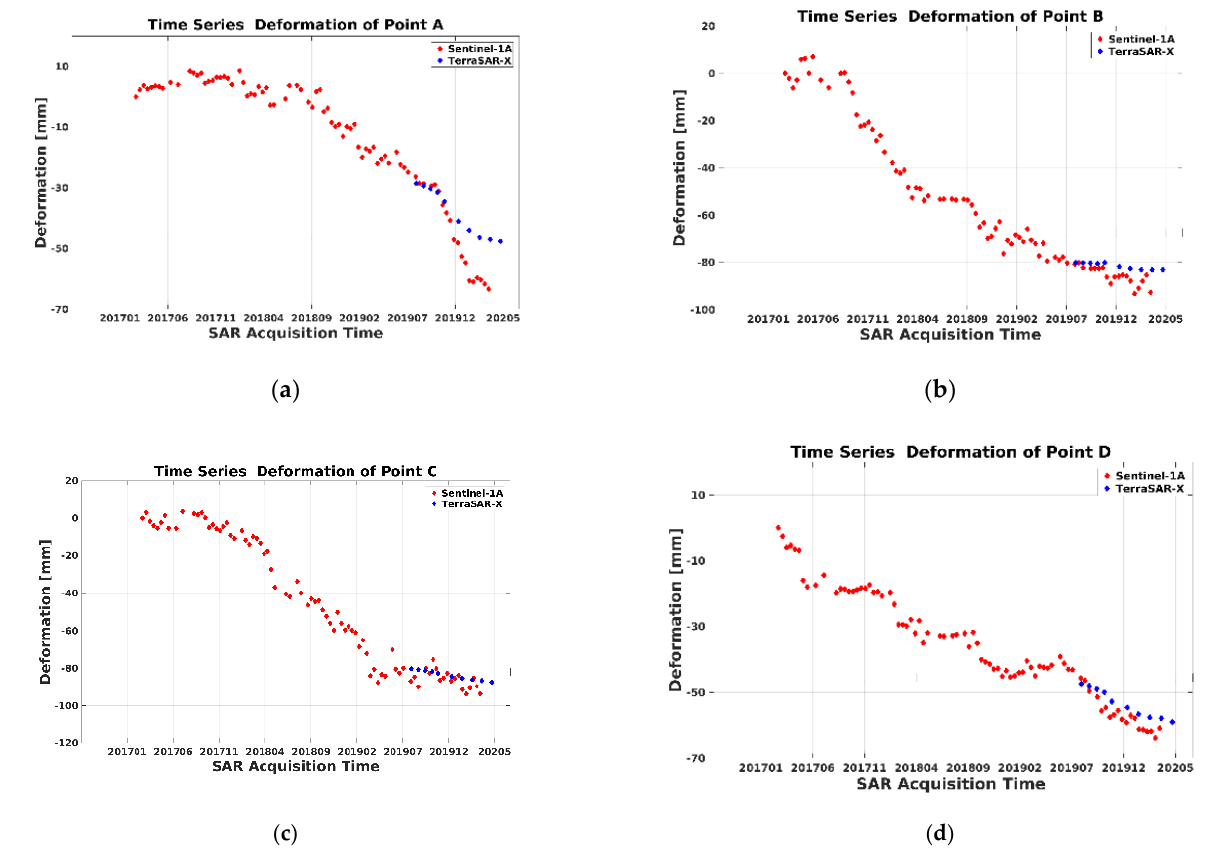
Figure 9. Detailed cumulative time series of land subsidence rates obtained from Sentinel-1A (red diamonds) and TerraSAR-X (blue diamonds) data. The investigated four main subsidence centers are located in ( a ) the Ali Center (A), ( b ) the Qianwan law building (B), ( c ) Vanke Cloud city (C), and ( d ) Yuehaimen zone (D). See also Figure 8.